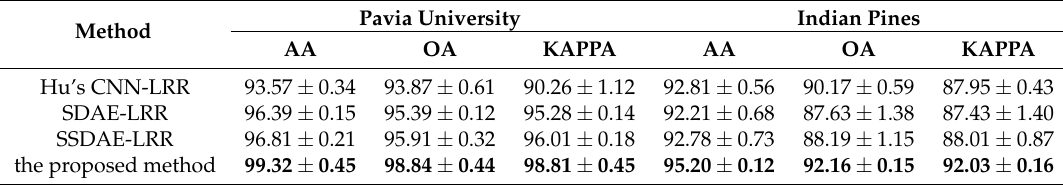
Table 8. Classification accuracy (%) of the proposed method and its three variants with different features on two